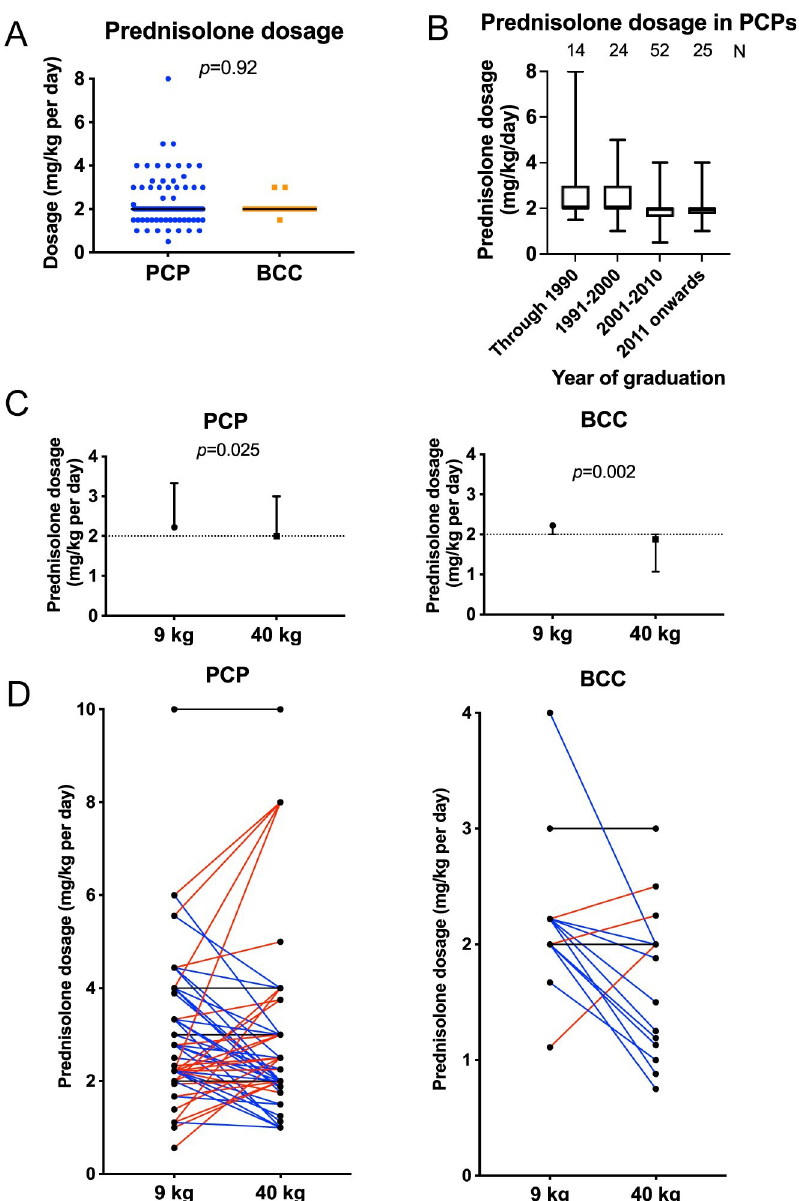
Fig 5. Respondents in primary care practice reported more varied initial dosages of prednisolone. ( A ) Graph showing initial glucocorticoid dosage used by those in primary care practice (PCP, n = 116) or board-certified clinicians (BCC, n = 22). Points represent individual responses, bars represent median. Inter-quartile range values were the same as the median in both groups. Groups compared with Mann-Whitney U test. ( B ) Boxplot showing initial glucocorticoid dosage selected by those in PCP according to year of graduation, annotated with number of respondents per group. Boxes show median with 25 th and 75 th percentiles, whiskers show minimum and maximum values. ( C ) Graphs showing dosage selected by those in PCP, n = 133 and BCCs, n = 21 in two clinical scenarios concerning initial dosage of glucocorticoids in a dog recently diagnosed with IMHA. Points represent median with inter-quartile range. Dotted lines indicate median value provided in Fig 5A to show difference from answers to that question. Responses compared with Wilcoxon signed rank tests. ( D ) Individual paired responses for those in PCP and BCCs for the two clinical scenarios. Individuals selecting the same dosage are marked with a black line, those using a higher dosage in the heavier dog are marked with a red line, and those using a lower dosage in the heavier dog are marked with a blue